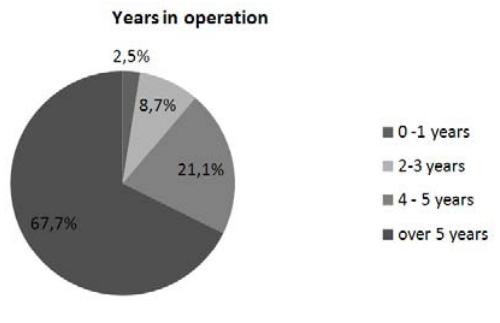
Fig. 6. Years in operation